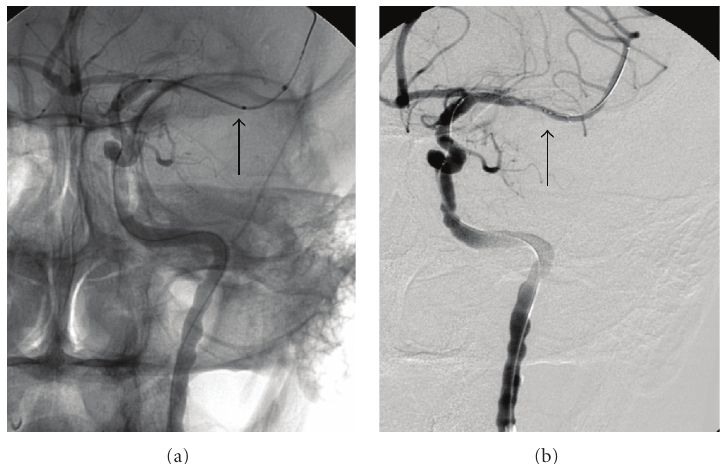
Figure 4: Angiogram before and after deployment of the intraarterial Neuroform Stent 3 × 20mm (arrows).